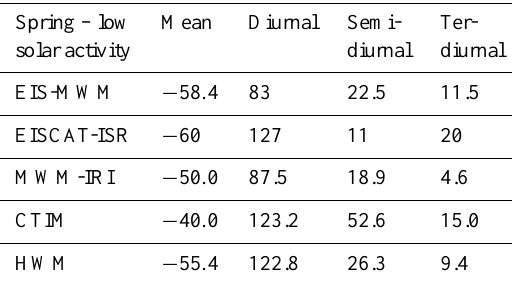
Fig. 1. The diurnal pattern of northward thermospheric meridional winds for spring season, low solar activity comparing the six tech- niques. Table 1. Spring season, low solar activity thermospheric meridional winds: a comparison of the mean, diurnal, semidiurnal and terdiur- nal components for five of the techniques producing thermospheric meridional neutral winds at Kiruna.